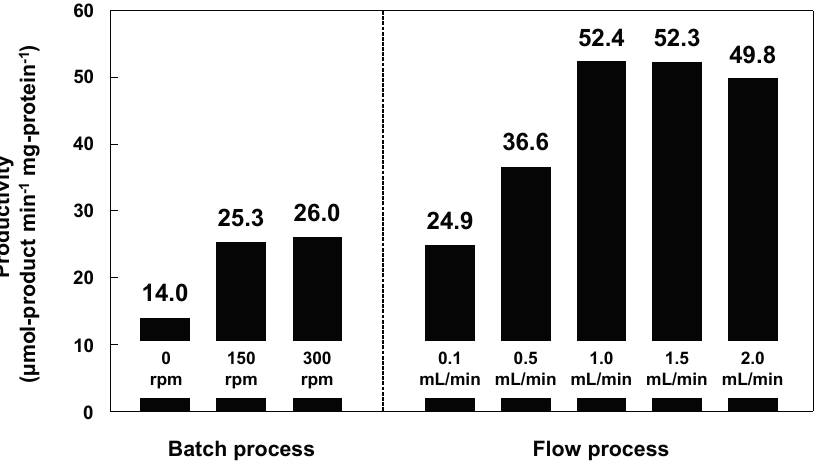
Figure 8. Production of 1-phenylethyl acetate in batch and flow processes using lipase immobilized on methacrylate-modified paper. The lipase content was equal in each case. Reaction temperature: 23 °C. Stirring rates in batch mode: 0, 150 and 300 rpm. Flow rates in flow mode: 0.1, 0.5, 1.0, 1.5 and 2.0 mL·min − 1